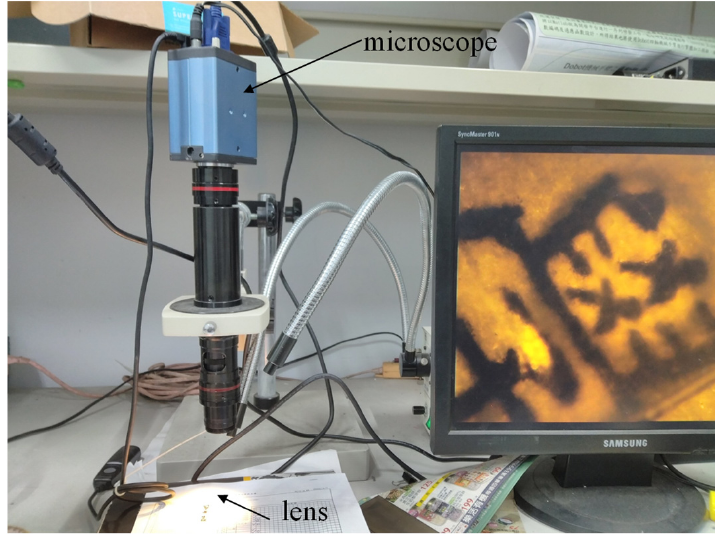
Figure 12. Setup of observing image formation by the microlens.